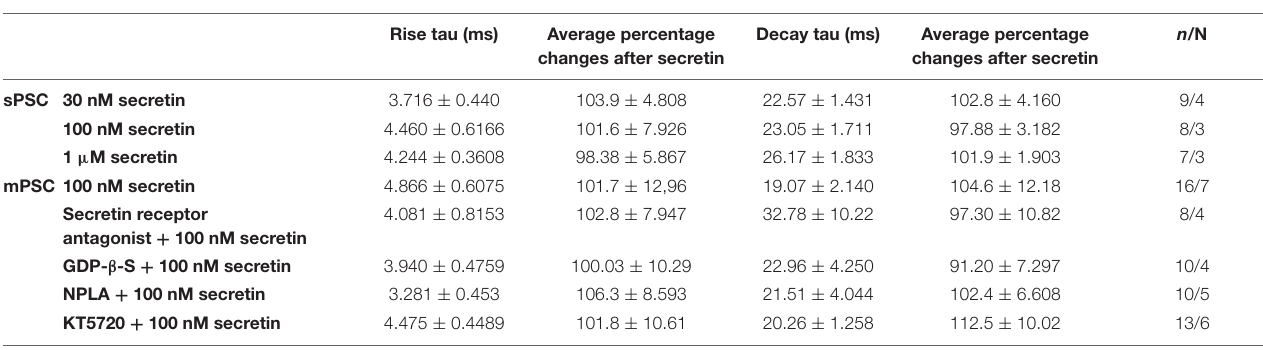
TABLE 5 | Changes in the rise τ and decay τ after 100 nM